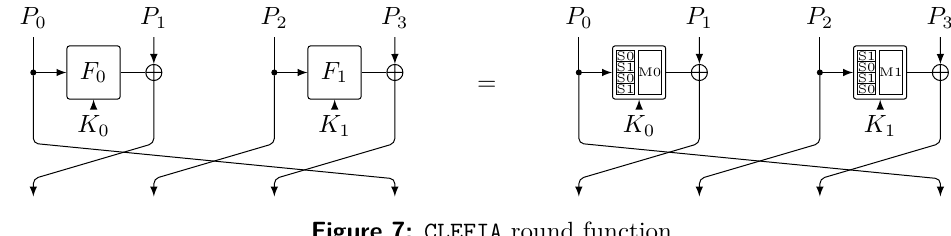
Figure 7: CLEFIA round